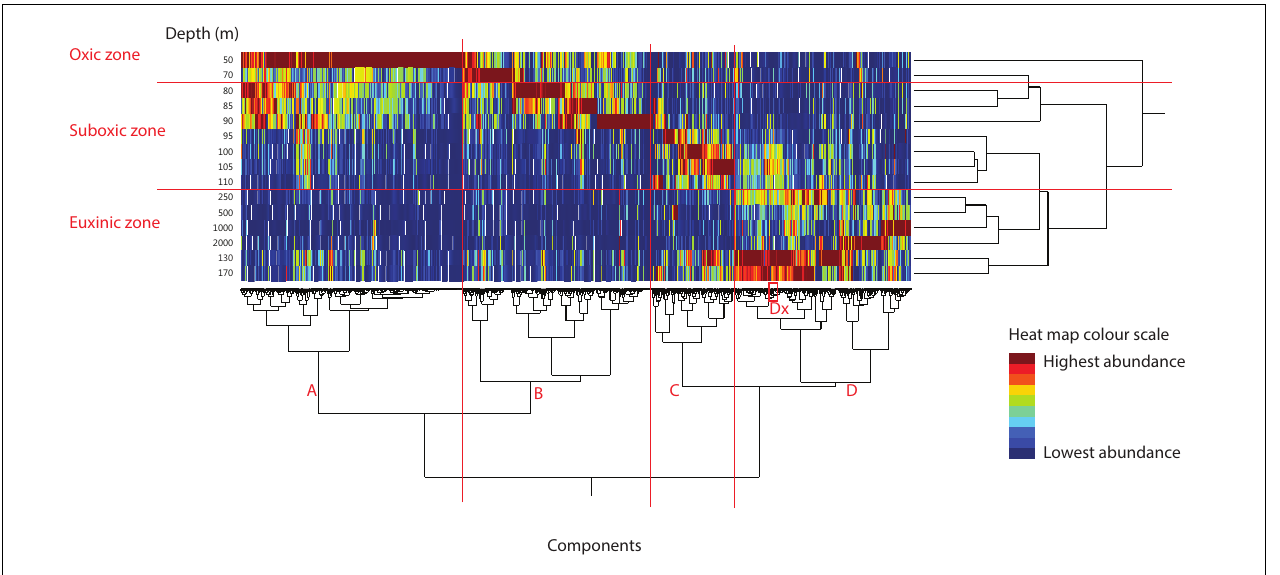
FIGURE 2 | Heat map of the peak areas of 14,648 component in Black Sea SPM from June 2013 as extracted by MZmine software. Color scheme represents component’s depth profile, red, highest abundance; and blue, lowest abundance. SPM extracts clustered by similarity in component distribution on the vertical axis and components clustered by similarity of depth profile through water column on the horizontal axis. Red annotations show the water column redox zones, as given in Table 1 .